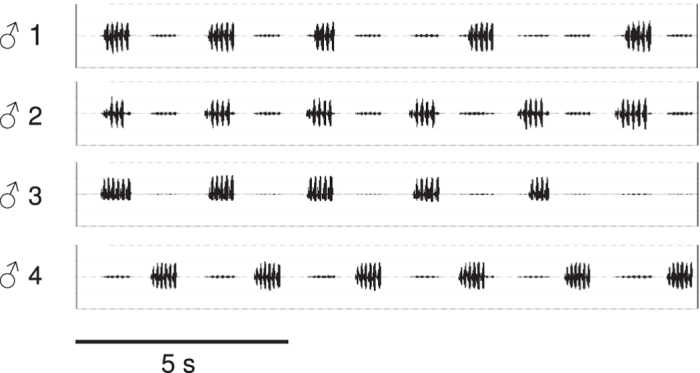
Elaborate chorusing in E. diurnus.Multi-channel oscillogram of a representative 15-s sample of calling recorded from a 4-male chorus in the Peyriac de Mer population (Fig. 4A). See Supplementary note S1 on the occurrence of both synchrony and alternation.